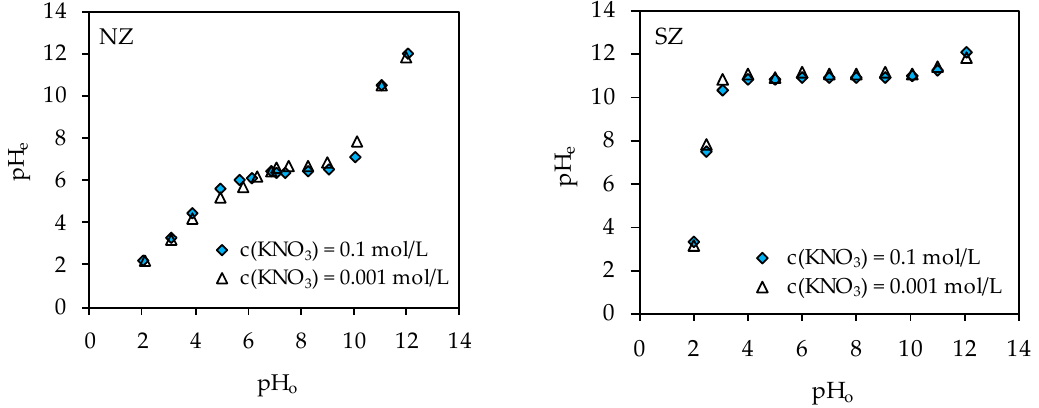
Figure 2. pH e vs. pH o in a suspension of NZ (left) or SZ (right) and an electrolyte solution of different ionic strengths. The results showed an increase in pH e in the range of pH o = 2–9 for NZ, i.e., in the range of pH o = 2–10 for SZ. In contrast, at pH o > 9 for NZ and pH o > 10 for SZ, a decrease in pH e relative to pH o was observed. This indicated that the zeolite surface possesses functional groups that are protonated in an acidic medium and deprotonated in an alka- line medium according to the following reactions [42]: